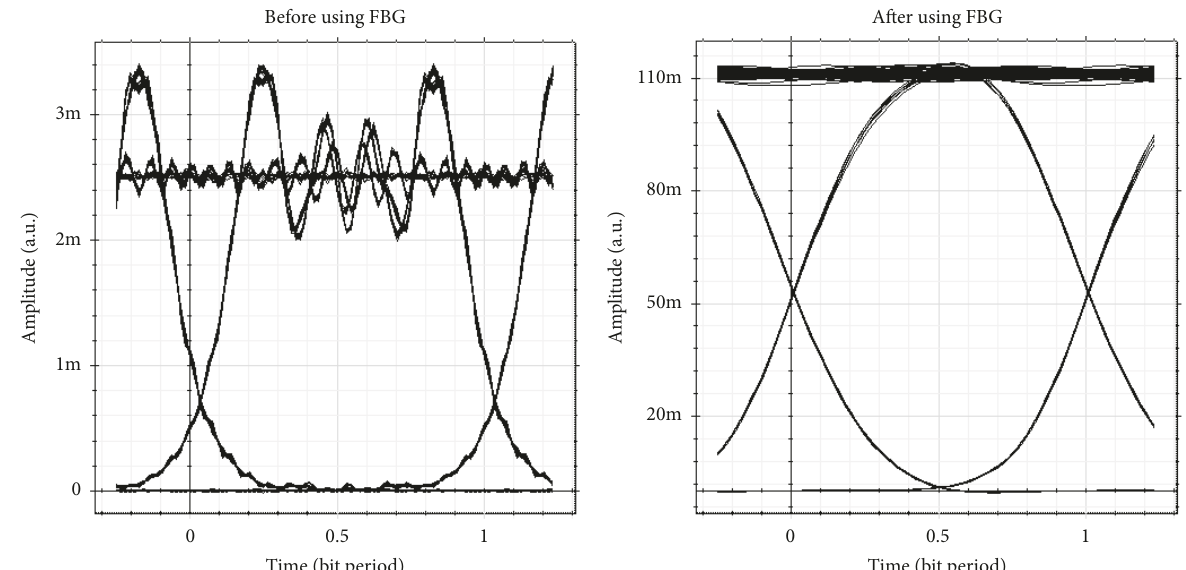
Figure 4: Eye diagram before using FBG and after using FBG.